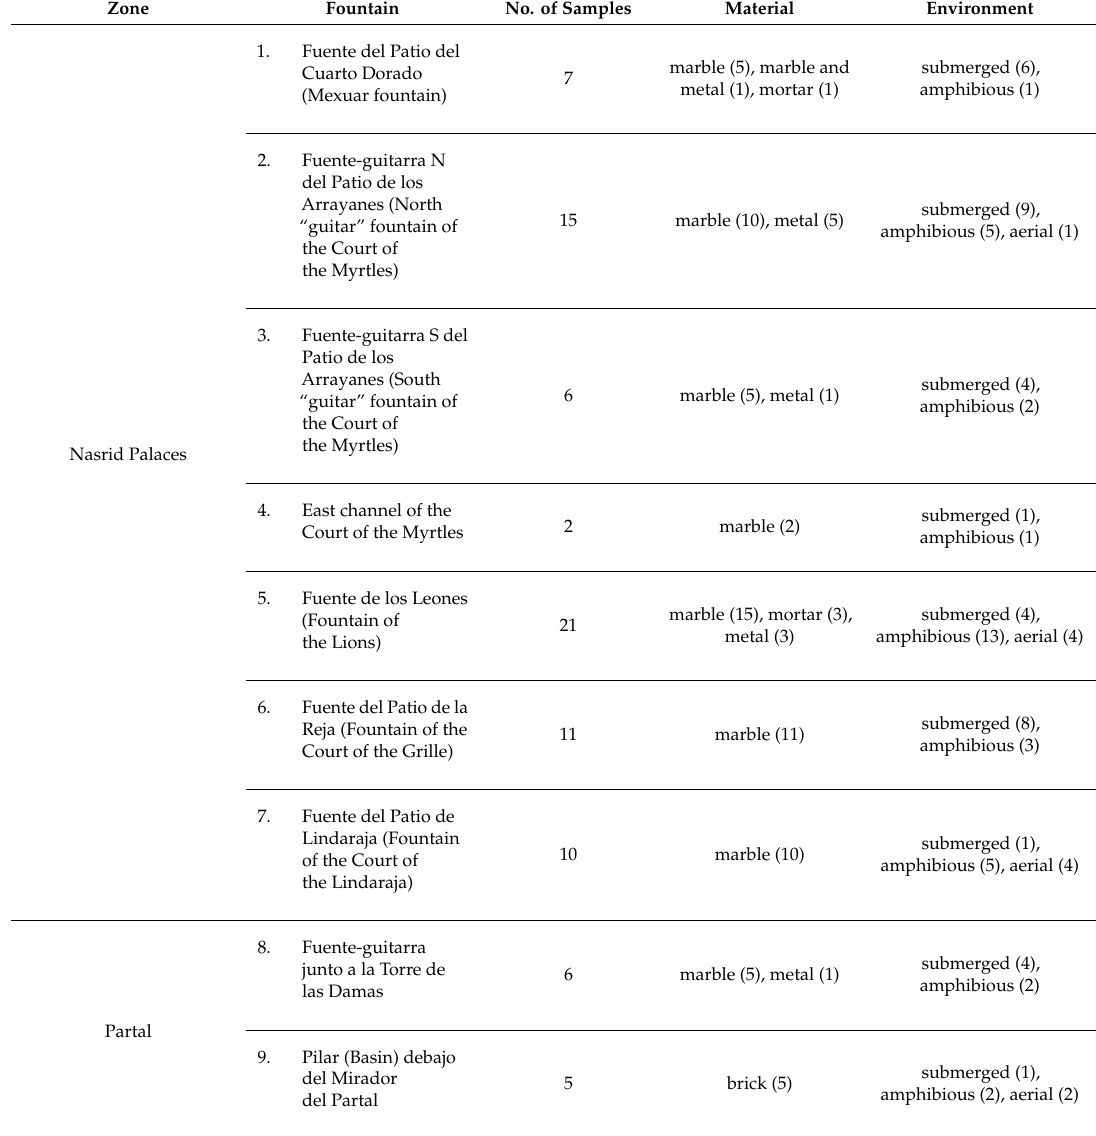
Table 1. Fountains studied in di ff erent areas of the Alhambra and numbers of samples collected. In the last two columns, in brackets, the numbers of samples taken corresponding to di ff erent materials and environments are